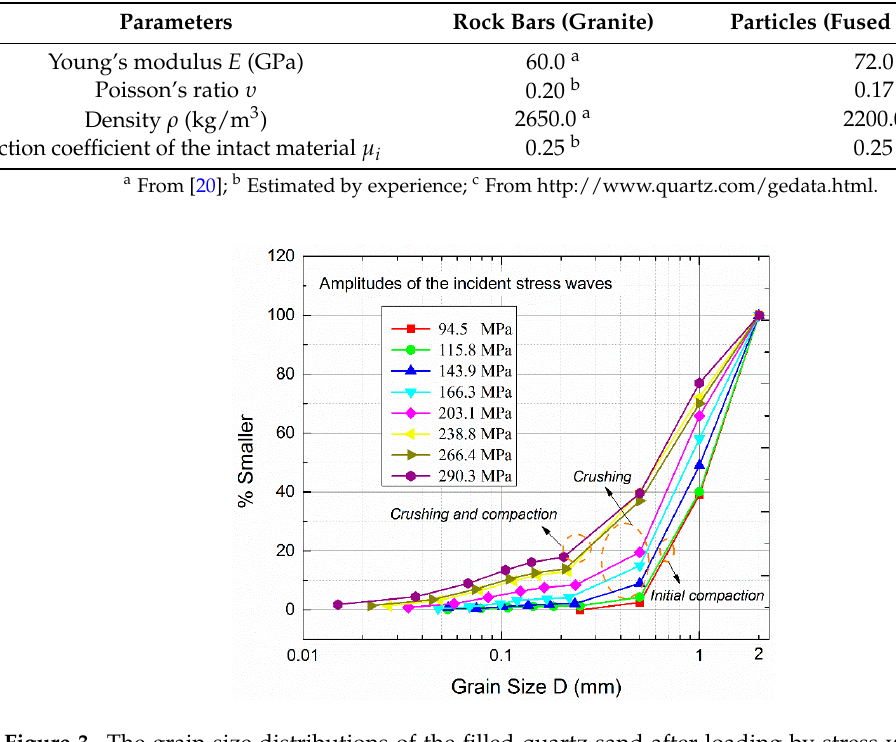
Figure 3. The grain size distributions of the filled quartz sand after loading by stress waves with different amplitudes (adapted from [27]).